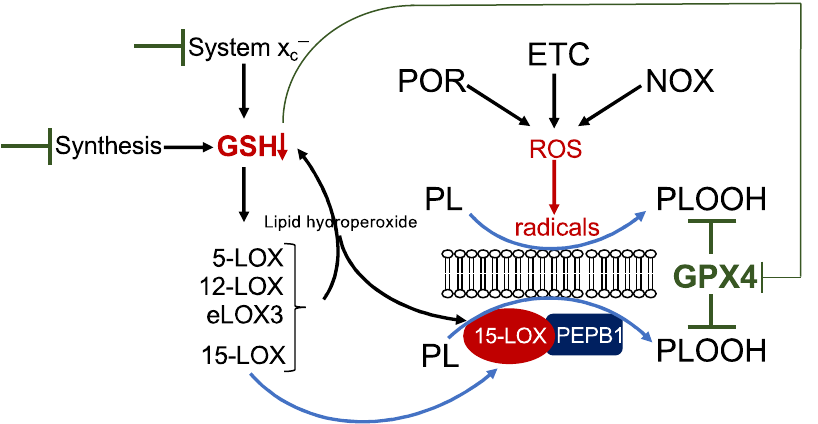
Figure 2. Mechanism of lipid peroxidation. Hypothetical model of phospholipid peroxidation leading to ferroptosis. Phospholipid peroxidation may be triggered either by radical formation due to reactive oxygen species (ROS) derived from cytochrome P450 oxidoreductase (POR), the electron transport chain (ETC), or NADPH oxidase (NOX), or enzymatically by 15-lipoxygenase (15-LOX). Association of 15-LOX with PEPB1 alters its substrate specificity towards membrane-bound PUFAs. Reduction in GSH by any means will increase the redox tone of the cell and thereby activate any LOX isoform. While 15-LOX can directly dioxygenate membrane-bound PUFAs, other isoforms indirectly cause accumulation of phospholipid hydroperoxides (i) by their primary reaction products, which activate 15-LOX, and (ii) by decreasing GSH levels, thereby attenuating GPX4